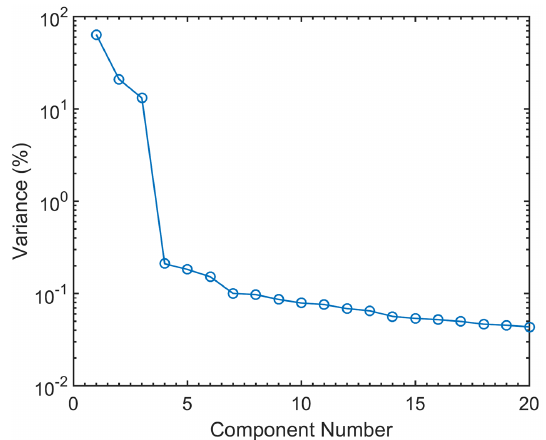
Figure 3. Variance plot obtained by the Principal Component Analysis of EXAFS operando spectra. Three components containing almost 98% of total spectra information stand out, the residuals represent the experimental noise.